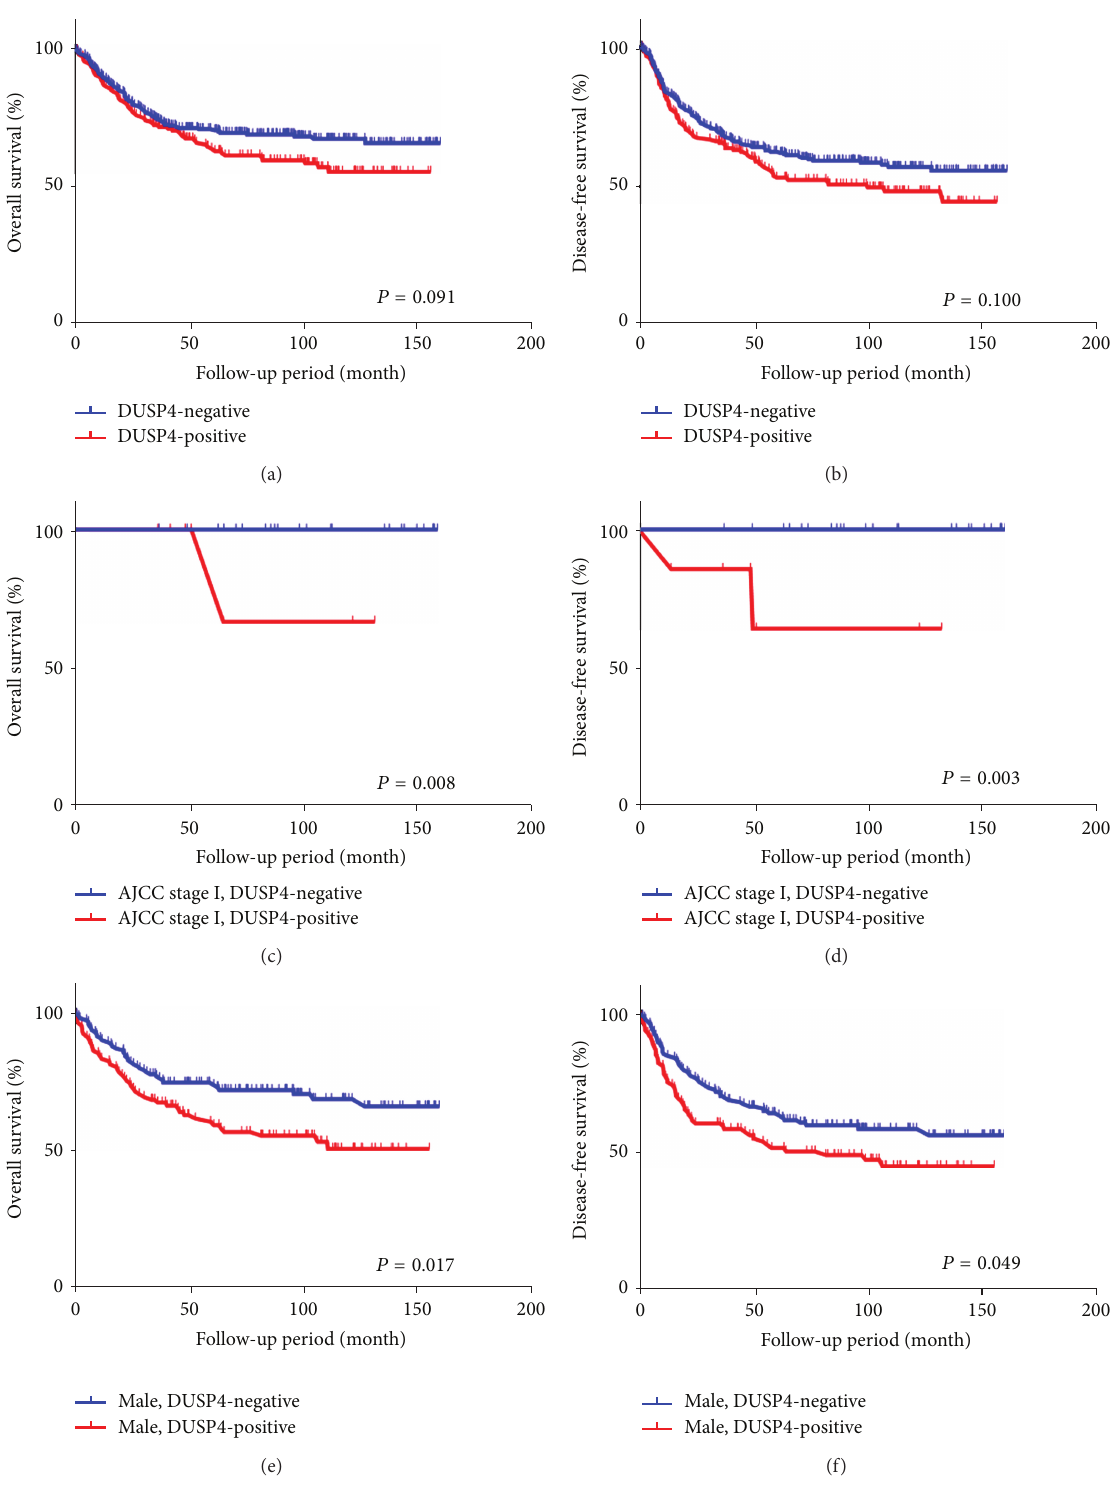
Figure 3: Cumulative overall and disease-free survival curves according to DUSP4 expression in all 439 patients with colorectal adenocarcinoma (a and b), AJCC stage I patients (c and d), and male gender (e and f) (Kaplan-Meier method with log-rank